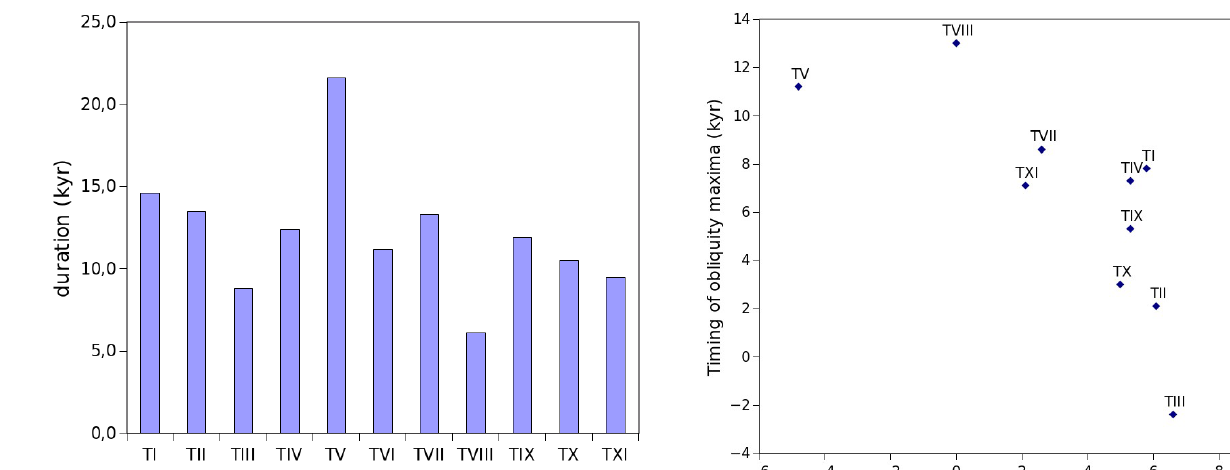
Fig. 2. Duration of terminations in our optimized model experiment Best.